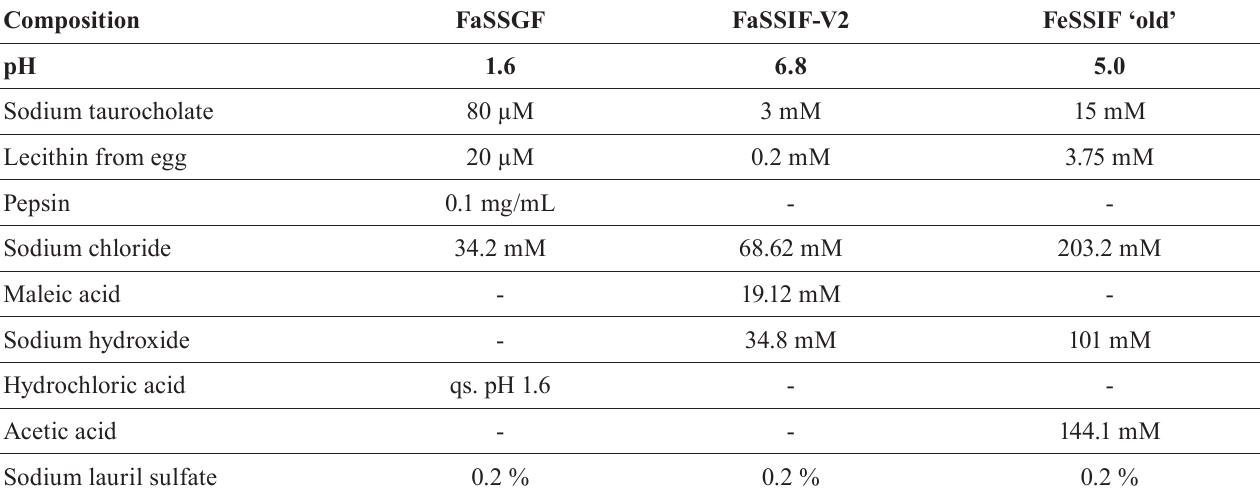
Table I - D issolution media simulating gastric (FaSSGF) and intestinal (FaSSIF-V2) fasted state conditions, and intestinal fed (FeSSIF ‘old’) state